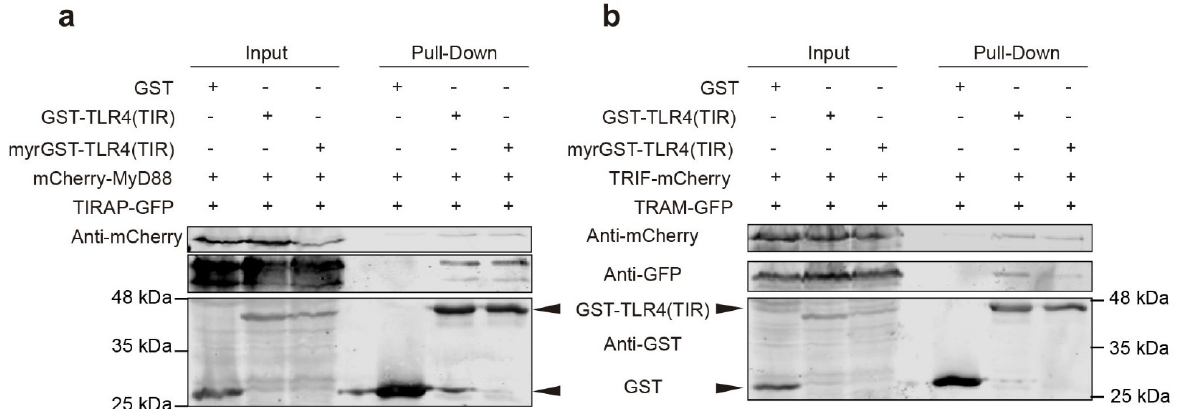
Figure 8. The TIR domain of TLR4 interacts with human TIR adaptors in yeast. YPH499 yeast cells were co-transformed with either GST, GST-TLR4(TIR), or myr-GST-TLR4(TIR) from pEG(KG) derivative plasmids and ( a ) mCherry-MyD88 plus TIRAP-GFP from pYES3 or YCpLG respectively or ( b ) TRIF-mCherry plus TRAM-GFP from pYES3 or YCpLG respectively. The (+) or (-) signs indicate presence or absence, respectively, of the indicated heterologous proteins in the yeast lysates loaded in each electrophoretic lane. Extracts were treated with glutathione agarose beads (GE Healthcare), followed by Western blotting analysis. Input lanes show the whole extract, whereas pull-down lanes display the precipitated proteins. Blots were developed using antibodies anti-mCherry (upper panels), anti-GFP (central panels), and anti-GST (lower panels).